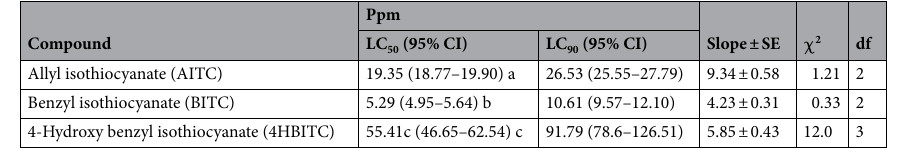
Table 4. LC 50 and LC 90 values of major chemical component of Brassica seed meal 24 h post treatment to late 3rd instar larvae of Aedes aegypti . LC 50 values for treatments followed by the same letter are not significantly different based on the lethal dose ratio value in which the 95% confidence interval (CI) does not include a value of 1 ( P = 0.05). LC 50 lethal dose ratio between AITC and BITC = 3.66 (3.404–3.935). LC 50 lethal dose ratio between AITC and 4HBITC = 0.34 (0.325–0.365). LC 50 lethal dose ratio between BITC and 4HBITC = 0.094 (0.087–0.102).